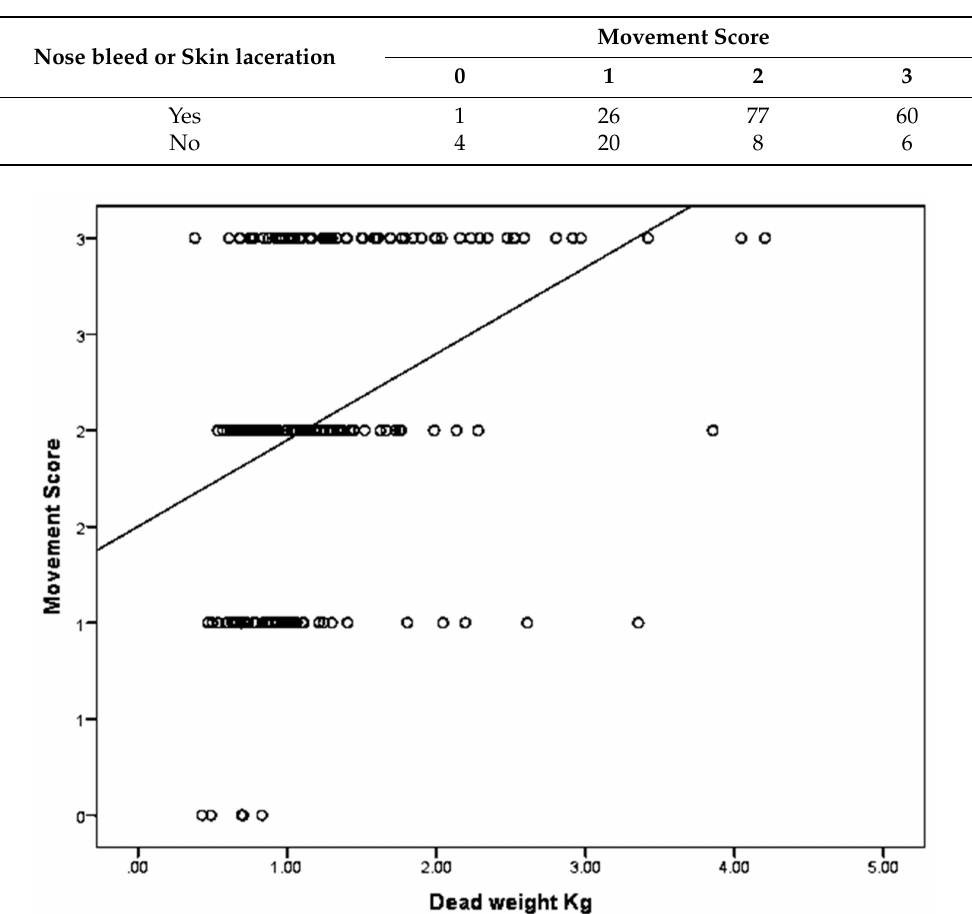
Table 5. The number of piglets that demonstrated a nose bleed or skin laceration for each movement score, where Score 0 = very little movement; Score 1 = some mild uncontrolled physical movement of limbs; score 2 = considerable uncontrolled physical movement of limbs; and Score 3 = gross uncontrolled physical movement.